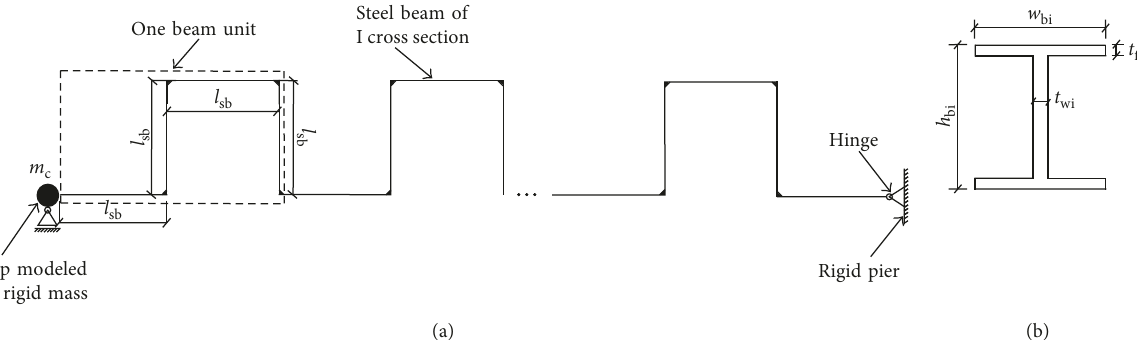
bu : number of beam units in one plane;